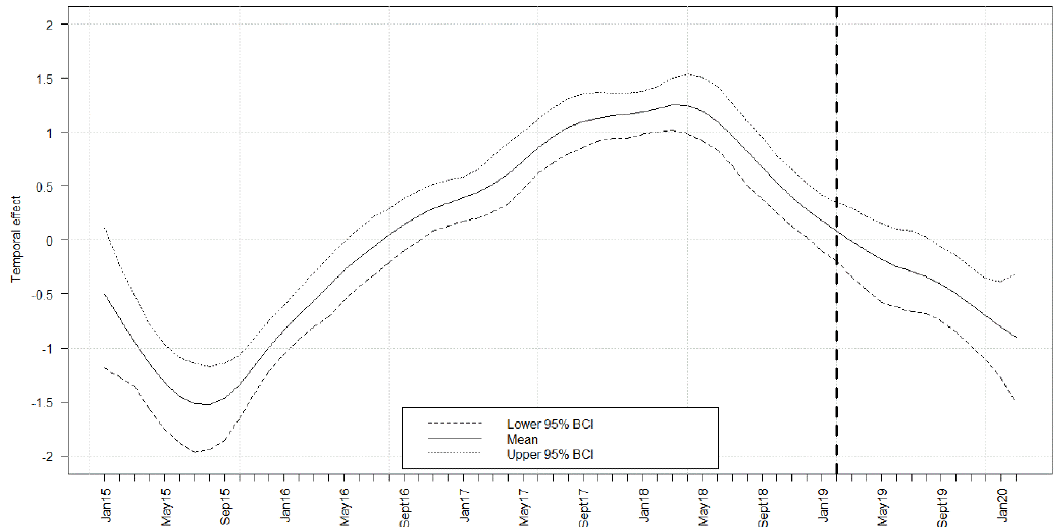
Figure 4. Median temporal effect on the logit prevalence for all samples that tested exclusively serologically positive, 95% Bayesian credible intervals (BCI) are indicated. The broken vertical line highlights February 2019, when the last ASFV-positive wild boar were detected by PCR.